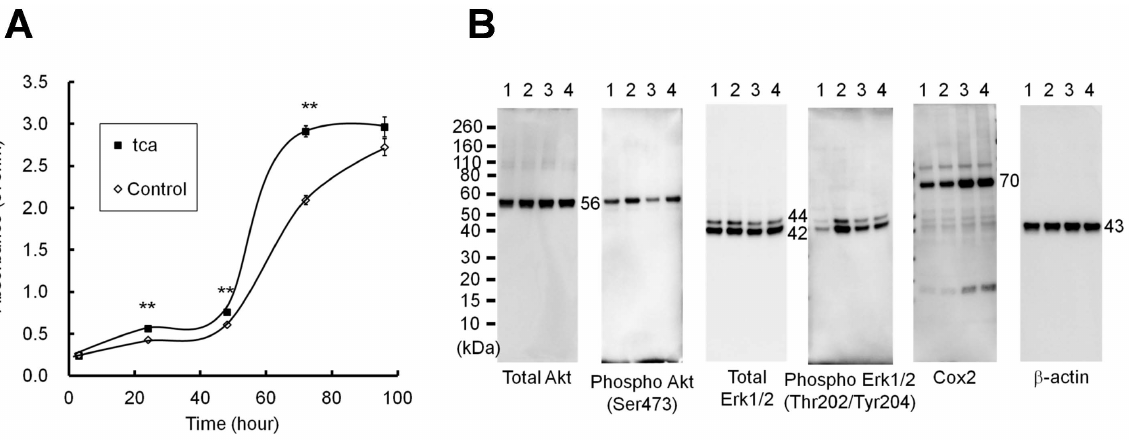
Figure 1. Effects of TCA exposure on ESCC-DR cell growth and signaling. Cell growth rates were evaluated using the MTT assay (A) Values represent the mean 6 S.D. of three independent experiments. TCA exposure promoted the growth of ESCC-DR cells compared with the control treatment (** P , 0.01). (B) Nos.1 and 2 are control cells and Nos.3 and 4 are tca cells. Nos.1 and 3 were treated without TCA. Nos.2 and 4 were treated with 2 mM TCA for 48 h. Ten micrograms of the whole cell lysate were subjected to western blotting with antibodies against total Akt, pAkt, total Erk1/2, pErk1/2, Cox 2, and b -actin. b -actin was used as an internal control. Molecular weights of Akt, Erk1/2, Cox2, and b -actin are indicated in the figures.